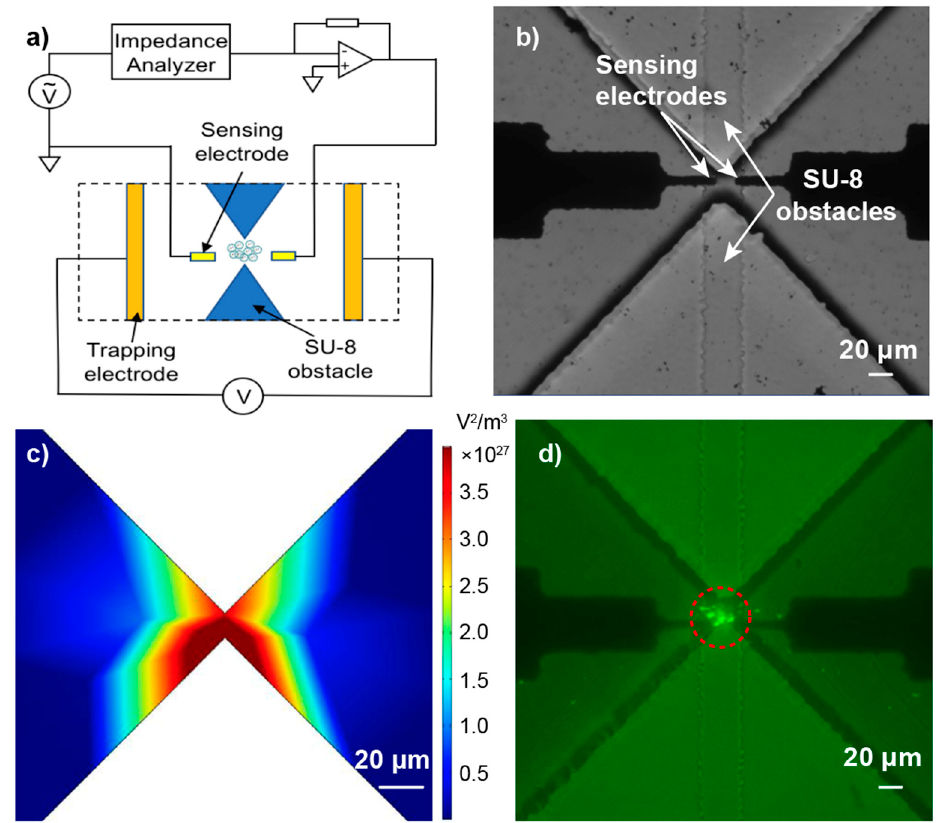
Figure 4. ( a ) The schematic of the impedance measurement system. ( b ) The bright-field microscopic image of the device. ( c ) The finite element analysis of the distribution of the electric field gradient across the opening created by SU-8; the suspending medium was 10 mM KCl and the applied voltage was 5 V/mm. ( d ) The fluorescence microscopic images showing the entrapment of 100 nm fluorescently tagged carboxylic acid polystyrene (COOH-PS) beads with a 5 V/mm bias applied across the opening for 5 min; the initial particle concentration was 2.3 × 10 12 /mL and the suspending solution was 10 mM